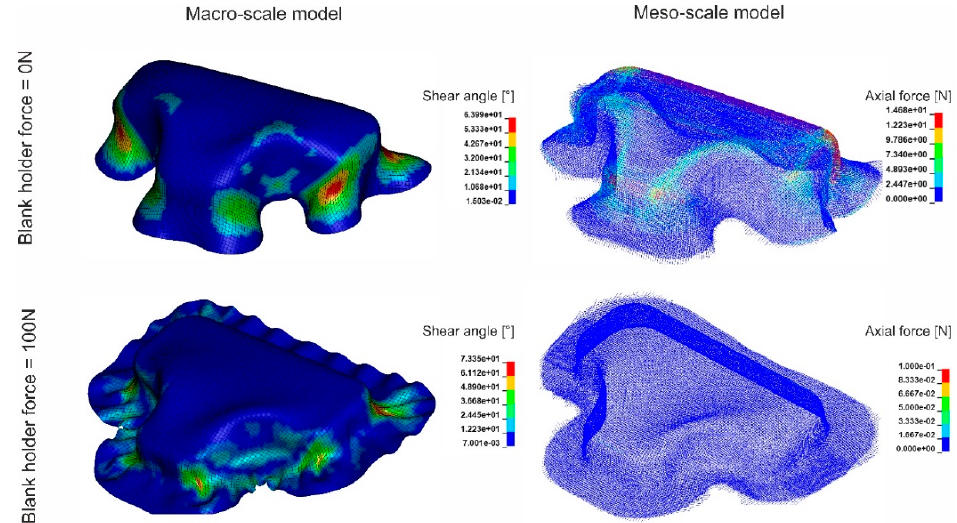
Figure 17. Model of the forming tool with T-shape geometry (arrow showing movement of the stamp).